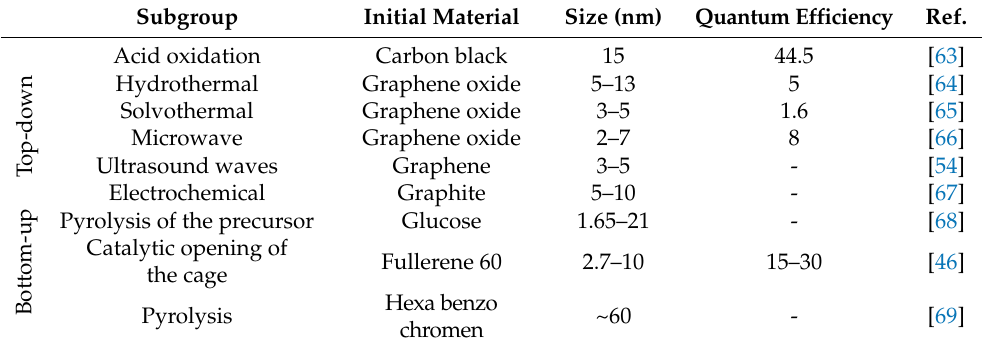
Table 1. Characteristics of top-down and bottom-up methods in the synthesis of